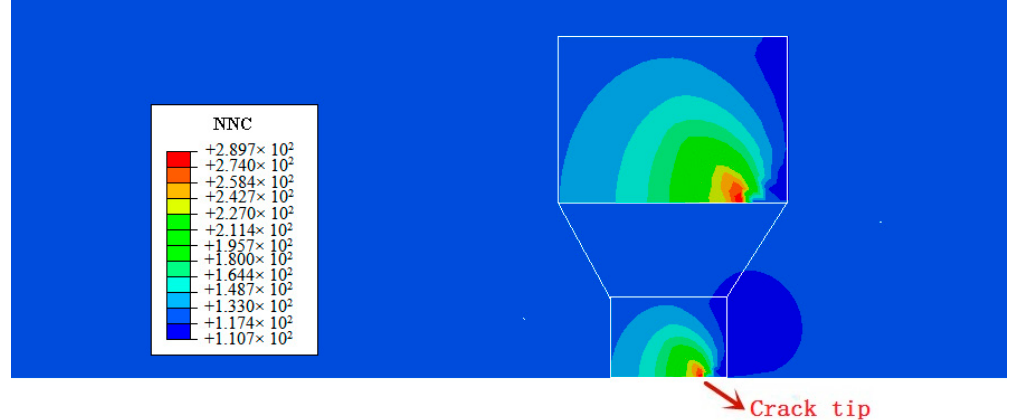
Figure 12. The contour plots of p hydrostatic pressure after the elastic-plastic analysis. Avg.: averaging threshold.